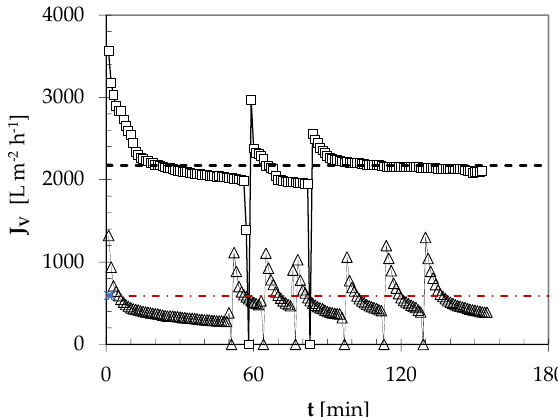
Figure 3. Time course of the instantaneous permeation flux (J V ) of two rough beer samples having high (~14 EBC-U: ∆ ) or low (~2 EBC-U: (cid:3) ) turbidity fed to the CFMF plant under the operating conditions given in the text, and periodic CO 2 backflushing. For all characteristics of rough beer samples, see Table 3. The average coefficient of variation for J V was ± 10%. The broken horizontal lines refer to the average permeation flux achieved in any of the two trials.